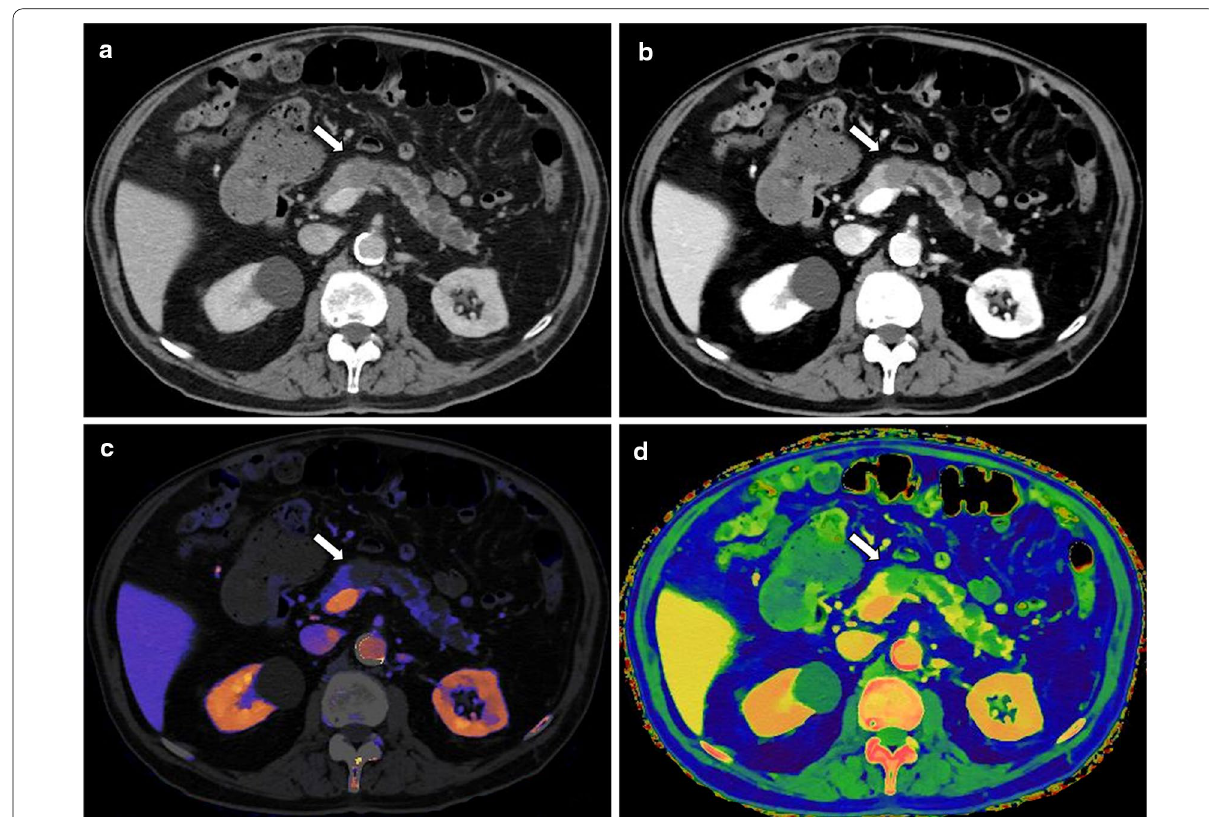
Fig. 6 Pancreatic adenocarcinoma in an 84-year-old man. On the late arterial phase image there is a lesion in the pancreatic body showing mild hypoenhancement compared to the normal pancreatic tissue ( a ). The lesion’s conspicuity is markedly improved using 50 keV mono-energetic images ( b ), iodine concentration overlay maps ( c ), and effective atomic number maps ( d